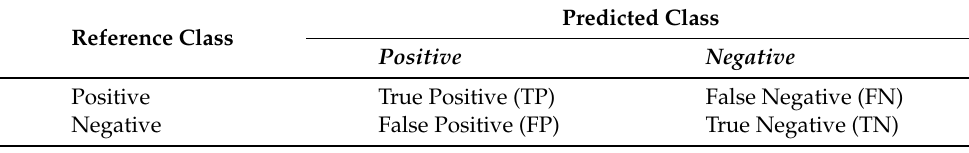
Table 2. Confusion